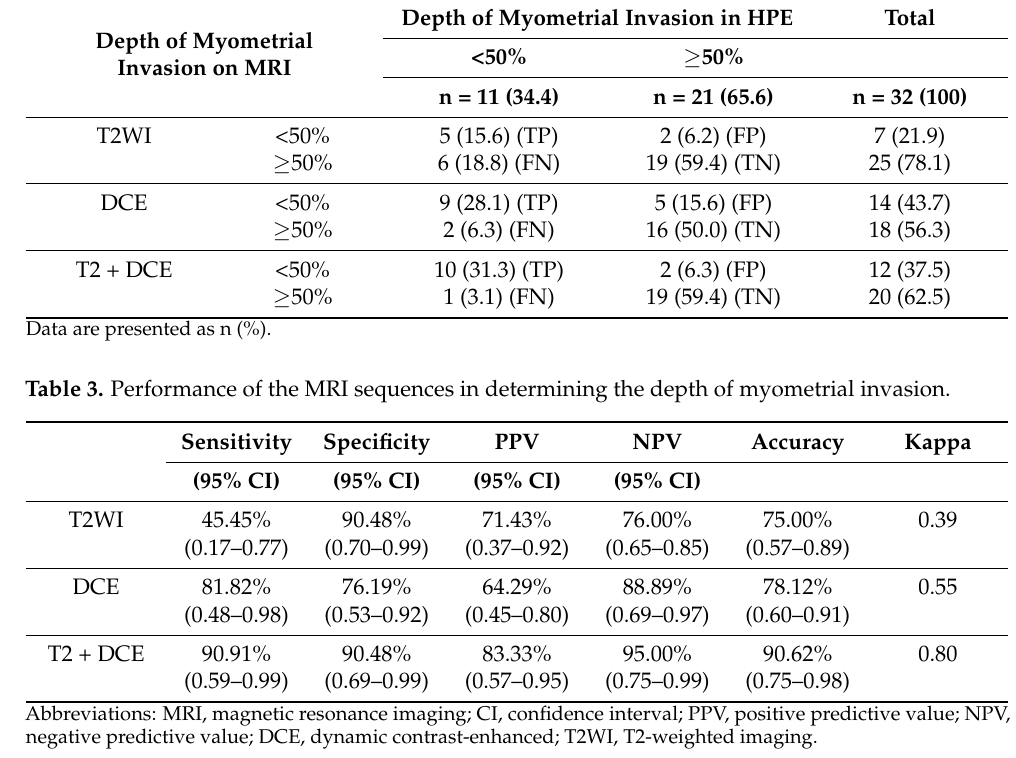
Table 2. Comparison of T2WI, DCE, and T2+DCE with HPE in determining the depth of myometrial invasion. Depth of Myometrial Invasion on MRI